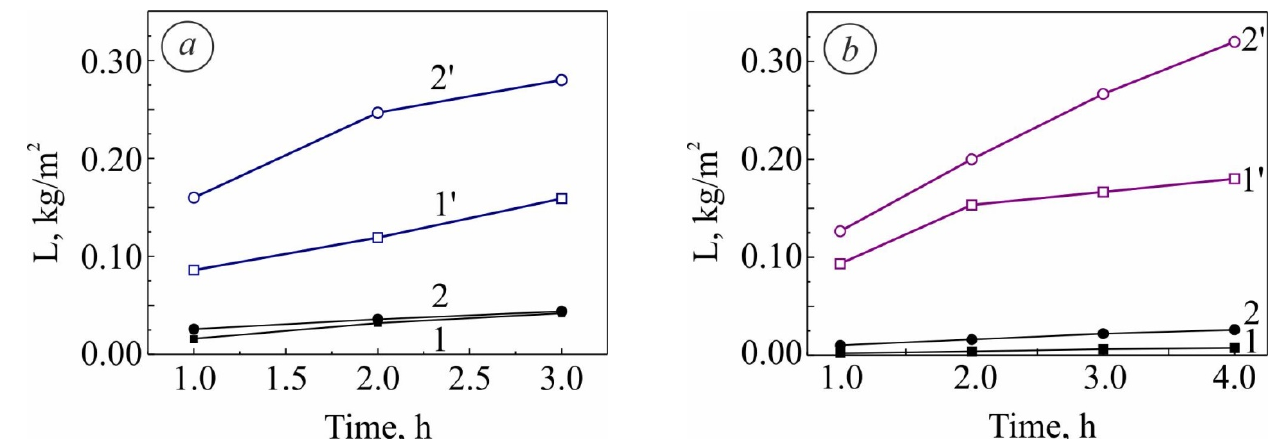
Figure 10. Cumulative wear mass loss for friction couples “AISI 420 steel (curves 1, 2)—counterbody (curves 1 / , 2 / )” at a contact pressure of 0.29 MPa (curves 1, 1 / ) and 0.42 MPa (curves 2, 2 / ): ( a ) the initial state; ( b ) after laser alloying with a plaster of 85Nb + 15% liquid glass.